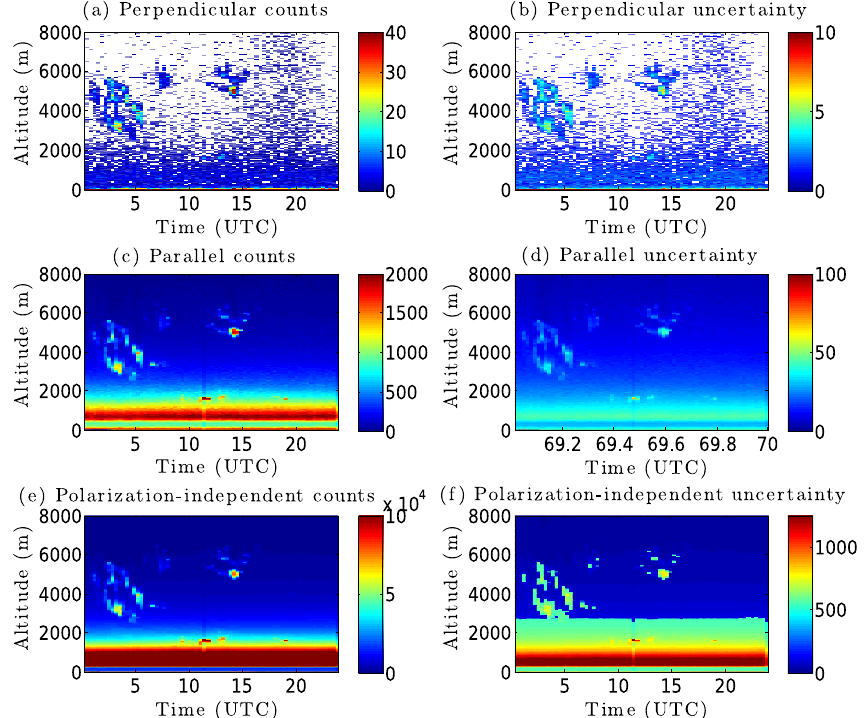
Figure 2. Corrected photocounts from 10 March 2013. (a, c, e) gives the corrected photocounts for the perpendicular (a) , parallel (c) , and polarization-independent Rayleigh elastic (e) channels. The corresponding absolute uncertainties, in units of photocounts, are plotted in (b, d, f) . All data points with a signal-to-noise ratio less than 1 have been removed and are coloured white. Because of the combined photon counting and analogue measurements at CRL, these uncertainties are not simply the standard deviation of the photocounts reported in the left column of plots. Resolution is 20min ×